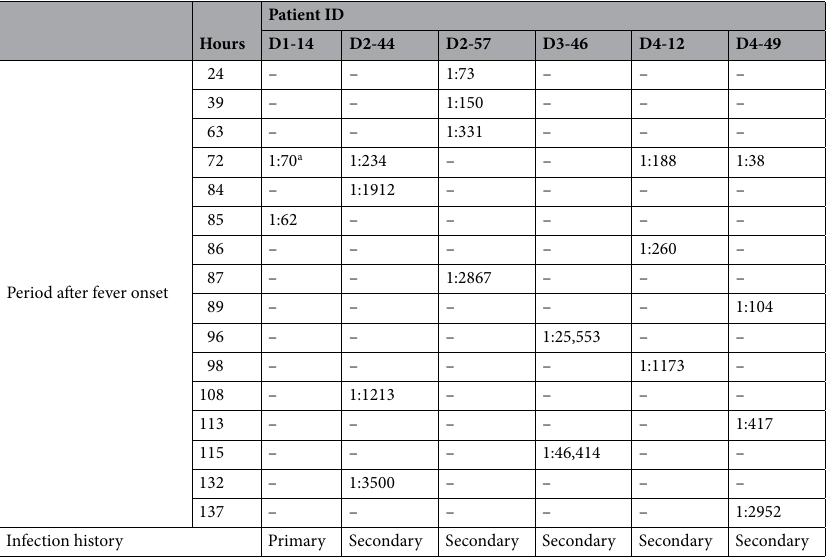
Table 1. Neutralizing antibody titers against the autologous virus. a Neutralizing antibody titer was expressed as the maximum serum dilution showing > 75% focus reduction